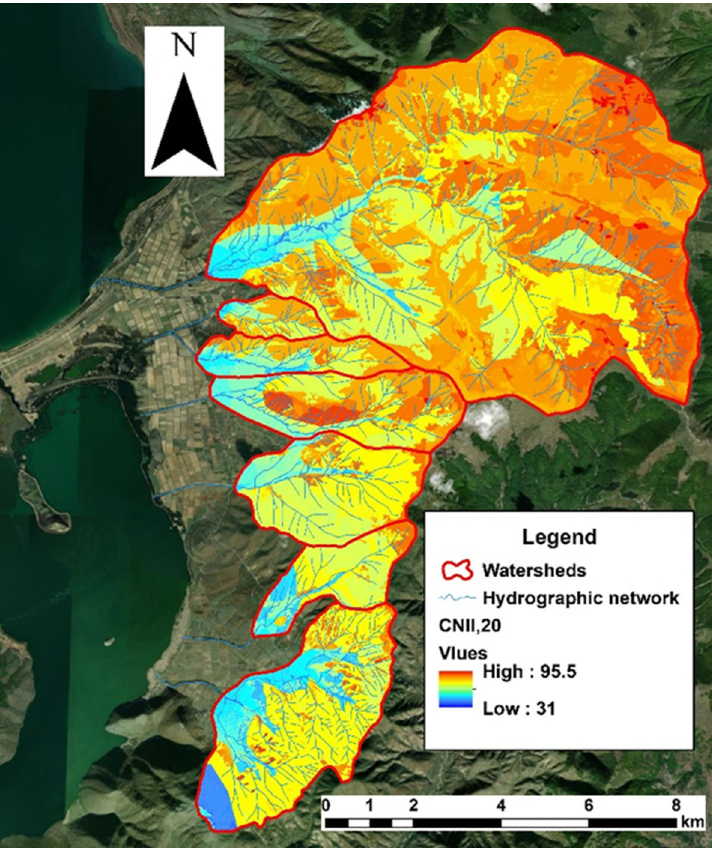
Figure 7. Spatial distribution of the CNII,20 for AMCII in the watersheds of the study area. Table 8. CNII,20 and CNIII mean value for all the